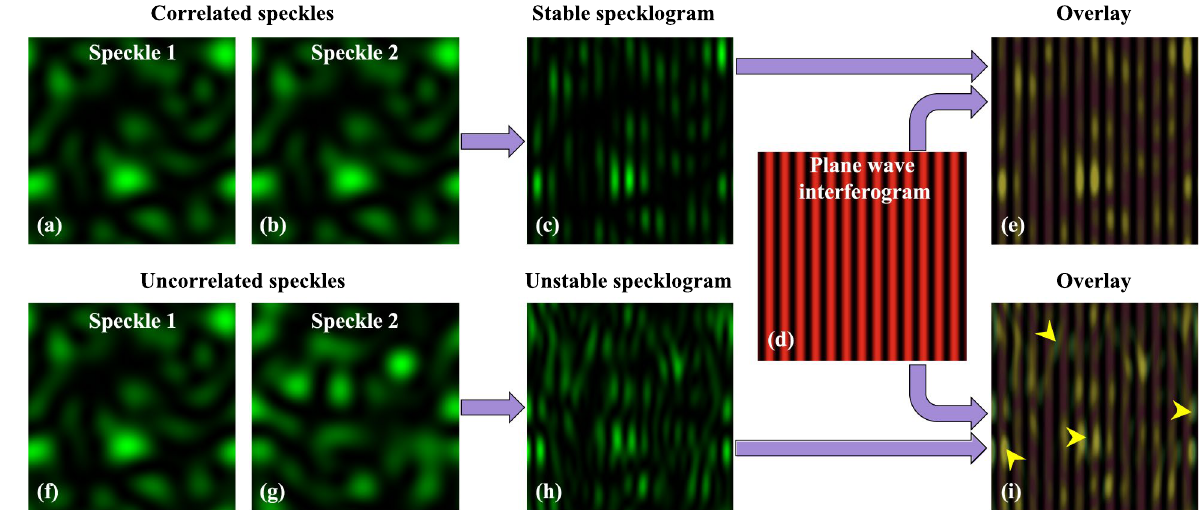
Figure 1. Representation of the superposition of correlated and uncorrelated speckle fields at the detector. ( a , b ) Identical speckle fields, ( c ) superposition of identical speckle fields, ( d ) superposition of two plane wavefronts, ( e ) overlay of the correlated speckle fields interferogram and plane wavefronts interferogram. ( f – h ) Non- identical speckle fields and their superposition, ( i ) overlay of uncorrelated speckle fields interferogram and plane wavefronts interferogram. The green regions exhibit the speckles in the images. For the correlated case, the interference fringes formed within the speckles follow the orientation of reference fringes and also do not show misalignment in the fringe positions from speckle to speckle. This is represented as a stable specklogram. Whereas, in the uncorrelated case, the fringes present in one speckle are not aligned to the fringes present in other speckles. This leads to the formation of randomly oriented interference fringes in the specklogram. This is termed as an unstable